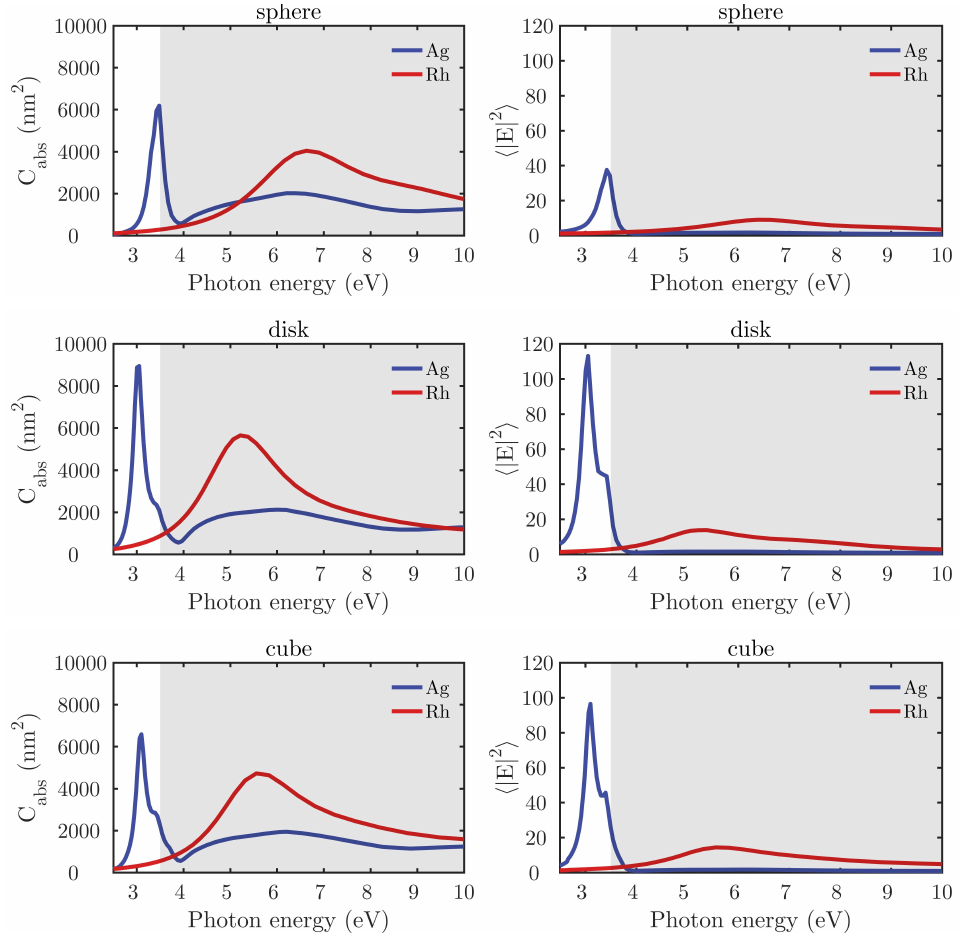
Figure 3. Absorption cross-section ( C abs ) ( left column ) and spectral electric field intensity ( (cid:104)| E | 2 (cid:105) ) averaged over the nanoparticle’s closed surface ( right column ) for spheres ( R = 18.6 nm), disks ( R = h = 20.5 nm), and cubes ( L = 30 nm) composed of Rh (red) or Ag (blue) illuminated under normal incidence, and embedded either in